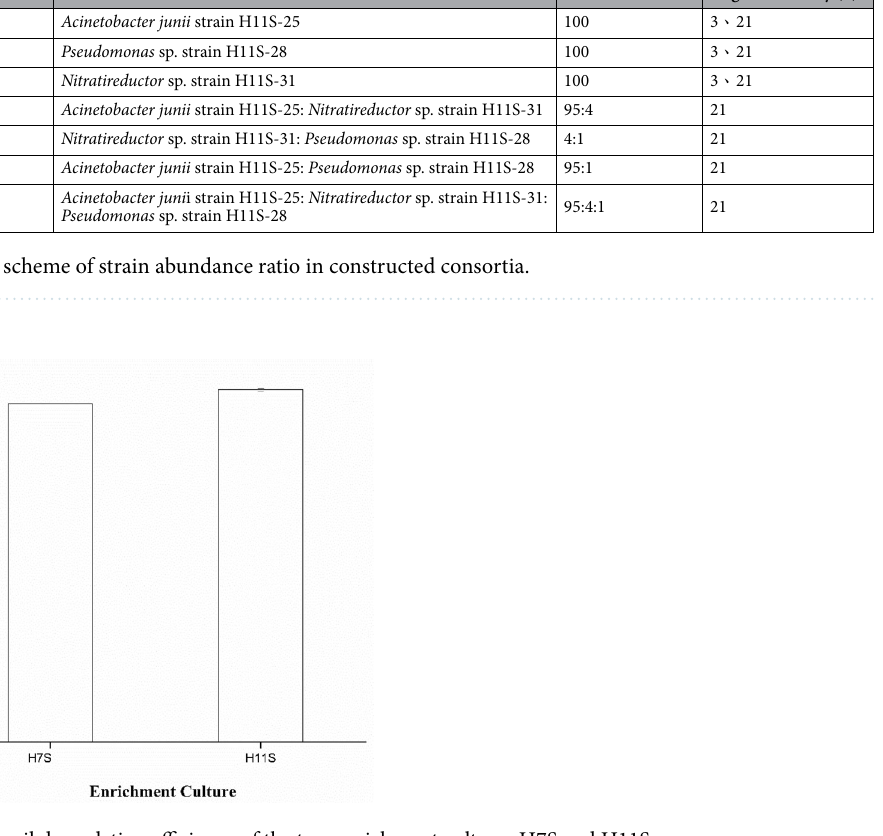
Figure 1. The oil degradation efficiency of the two enrichment cultures H7S and